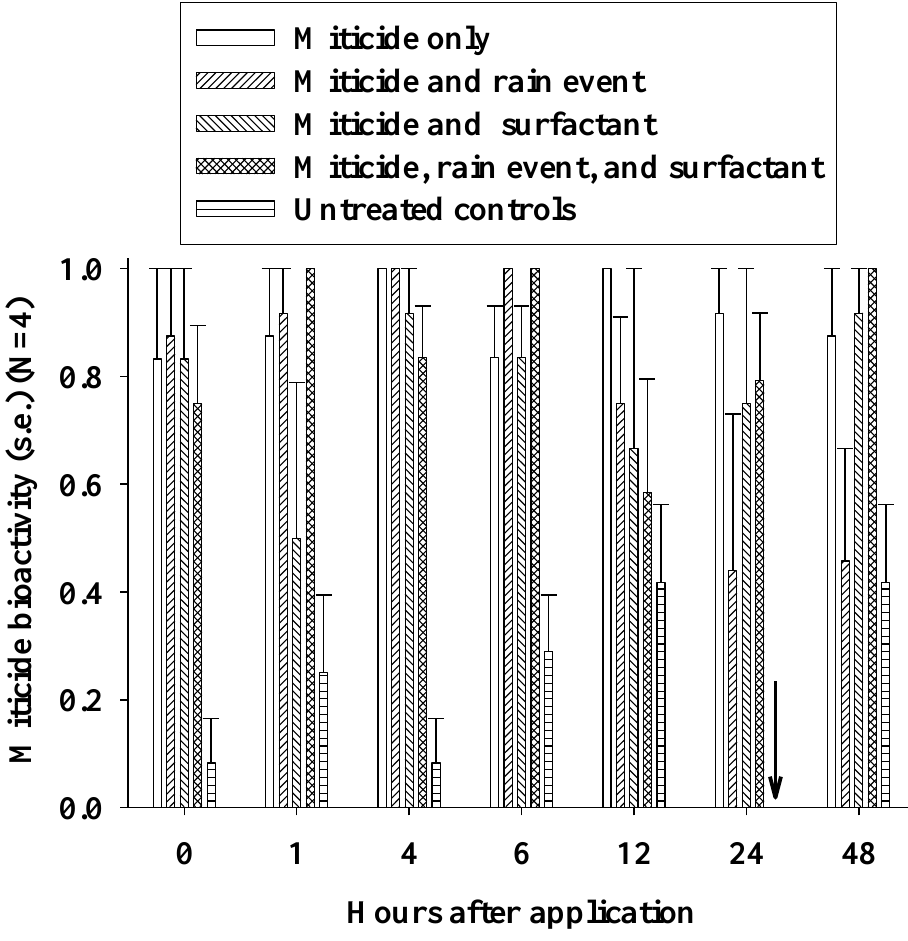
Figure 2. Average miticide bioactivity (spider mite mortality) from different treatments. Statistical analyses of spider mite bioassay results are presented in Table 1.